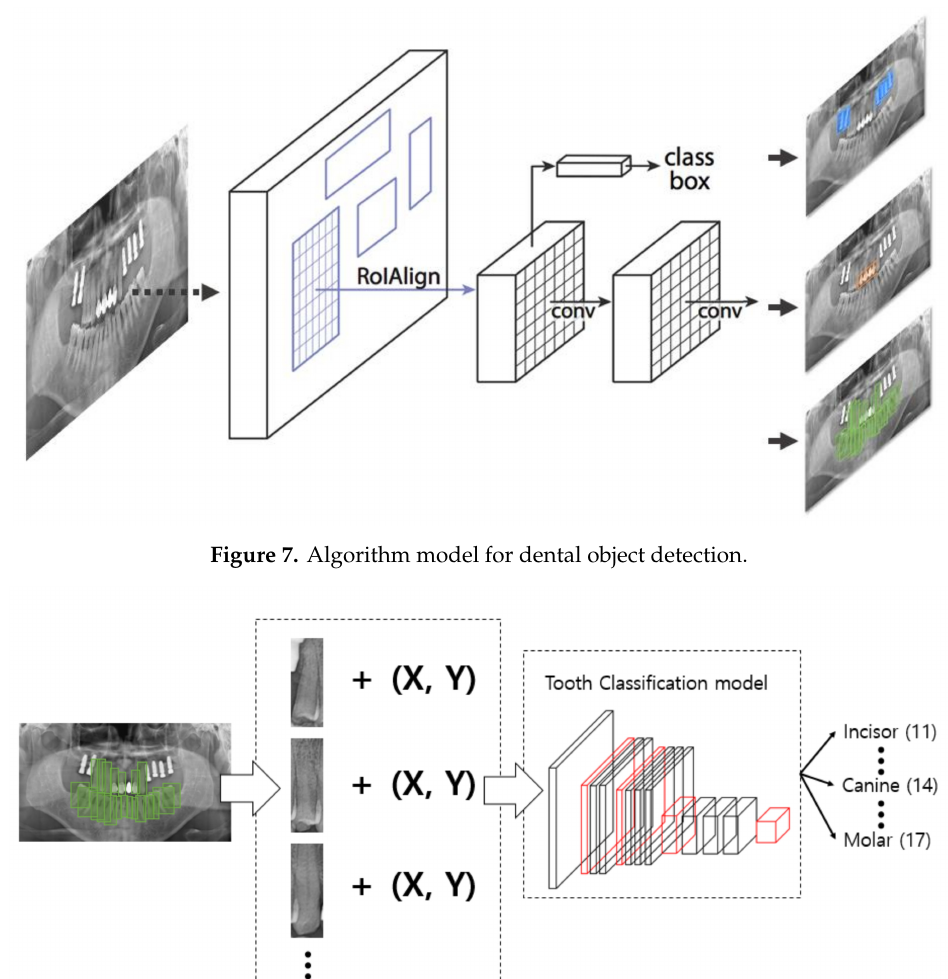
Figure 8. Tooth numbering